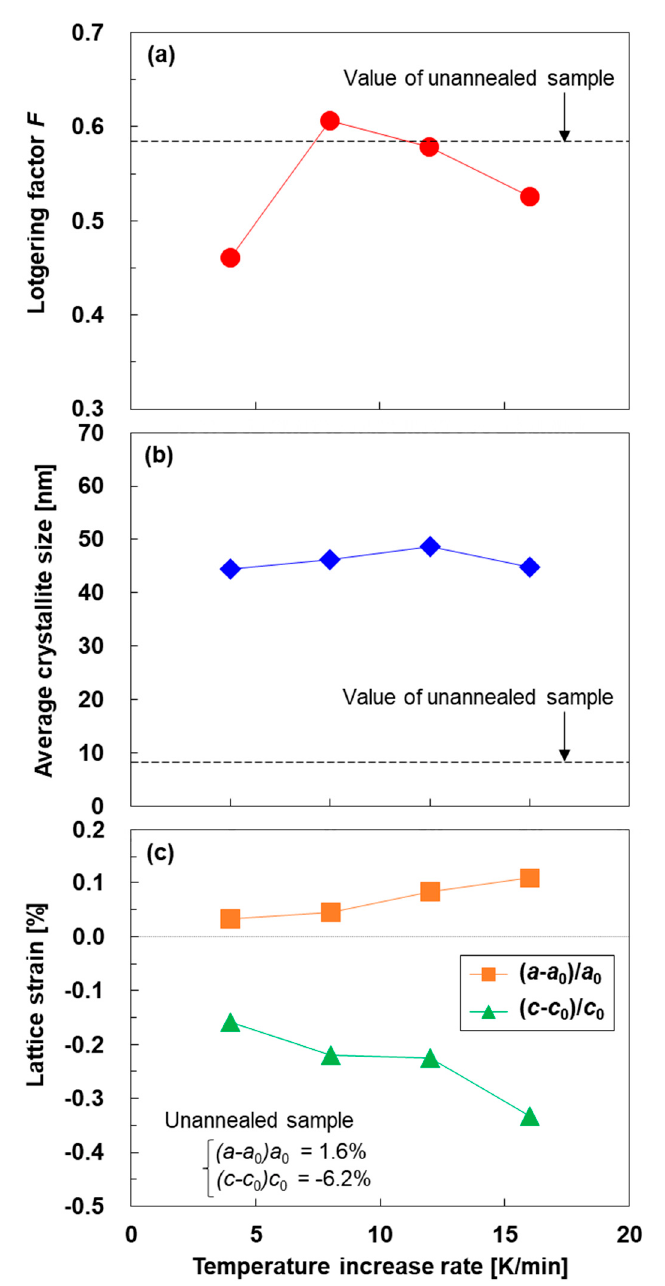
Figure 4. Crystallographic properties of the various Bi 2 Te 3 thin films determined from the XRD analysis: ( a ) Lotgering factor F , ( b ) crystallite size, and ( c ) lattice analysis: ( a ) Lotgering factor F , ( b ) crystallite size, and ( c ) lattice constants.